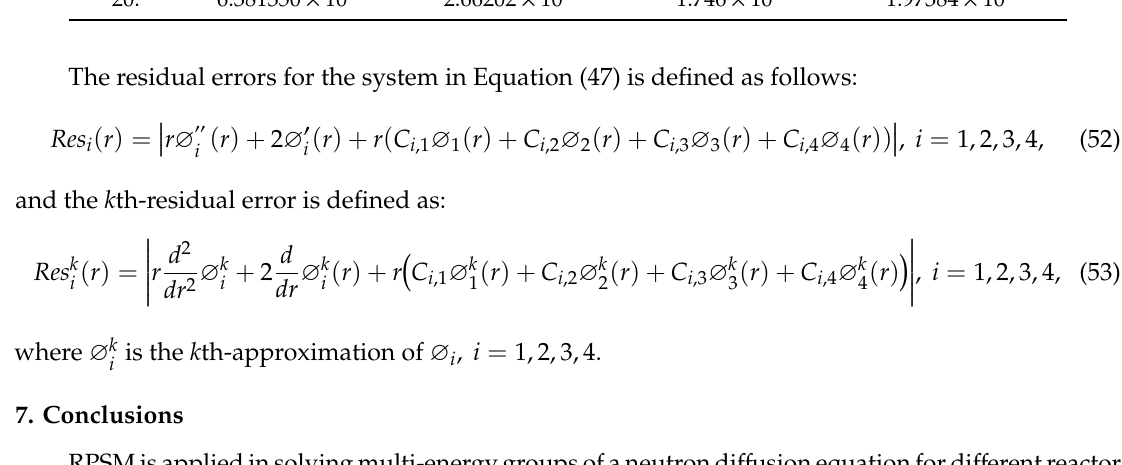
Table 18. The value of the 10th-residual error ( Res 10